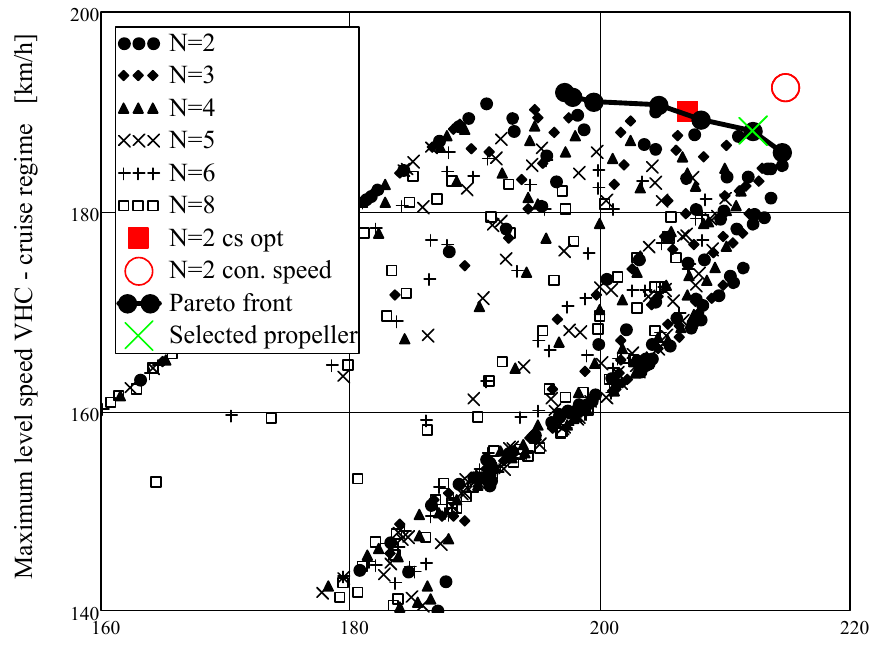
Table 5. Point on the Pareto front for take-off distance (take-off engine regime) and maximum rate of climb (take-off engine regime) (see Figure 10).